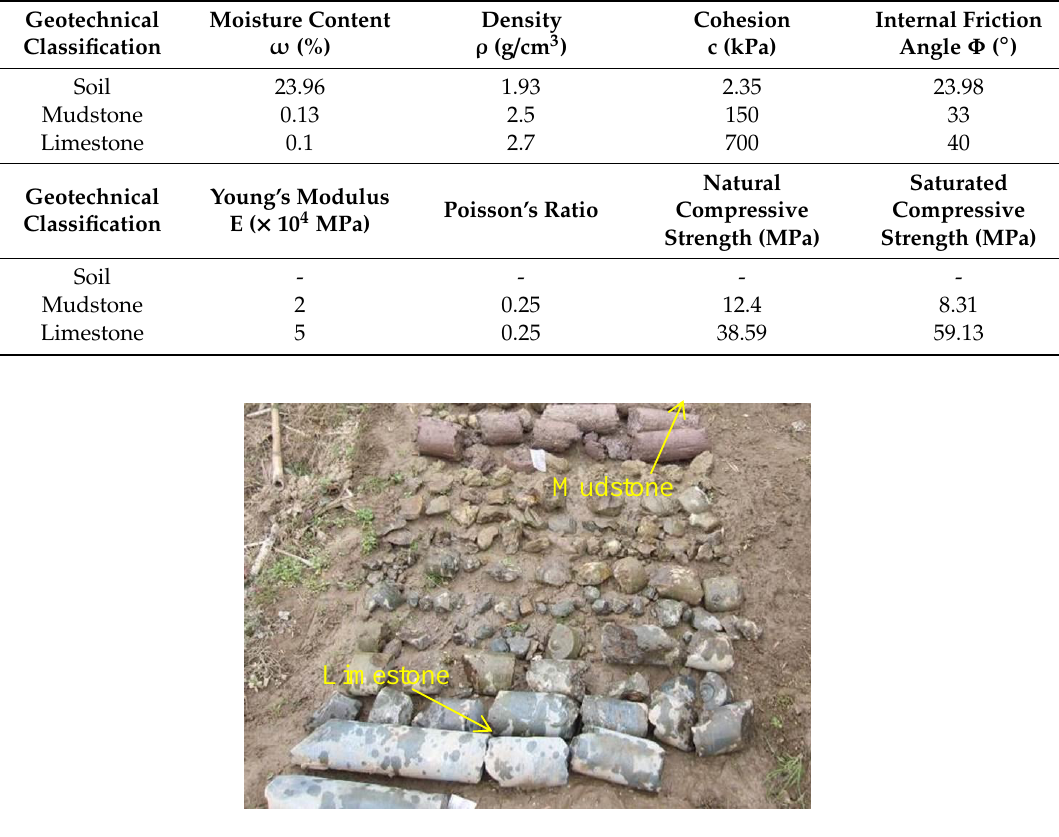
Table 1. Experimental parameters of geotechnical materials in the survey area.